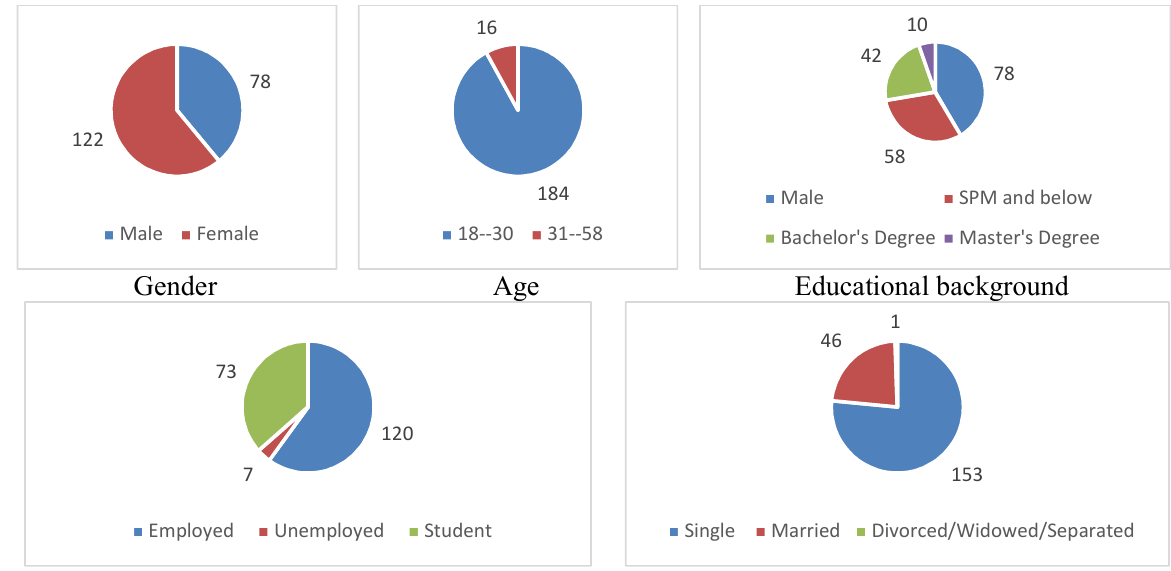
Fig. 1. Personal characteristics of the participants